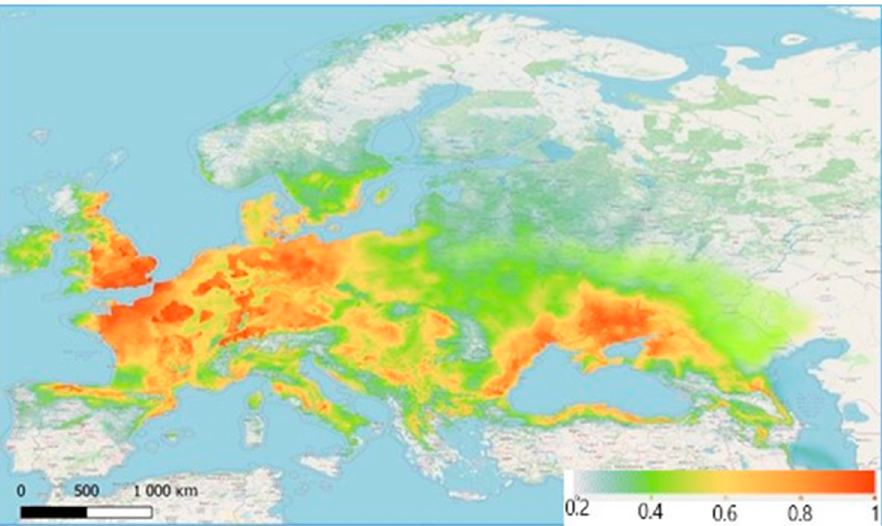
Figure 4. Current bioclimatic range of Z. tenebrioides : the most favourable zones for habitation are red (comfort index = 0.80–0.98), the close-to-optimal regions are orange (comfort index = 0.60–0.79), the less-suitable regions are yellow (comfort index = 0.40–0.59), the unsuitable regions are light green (comfort index <